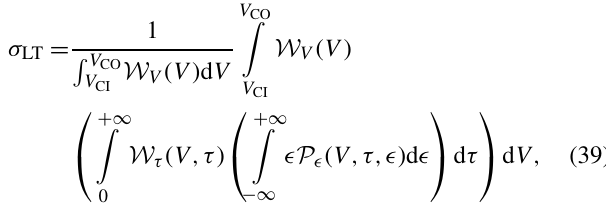
where the innermost integral represents the wind-speed- specific and TI-specific standard deviation of the observation error, σ ( V,τ ), which was previously computed and reported in Fig. 14. This quantity is then weighted by the probability of each wind speed and TI values to occur at this specific site, as given in Fig.